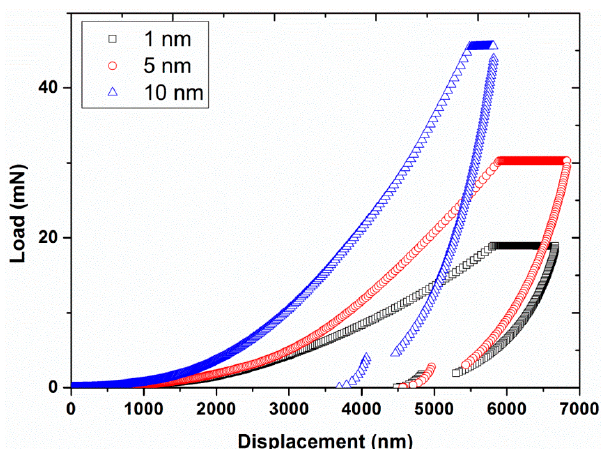
Figure 1. Indentation load as a function of displacement for the three different amplitudes (1, 5, and 10 nm) at a frequency of 45 Hz and strain rate of 0.05 s − 1. Polymers 2020 , 12 , x FOR PEER REVIEW